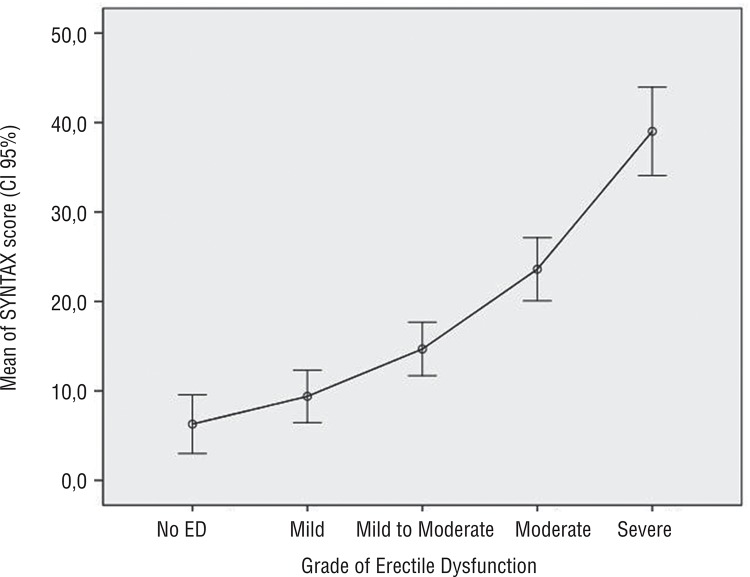
Grade of ED according to Syntax Score